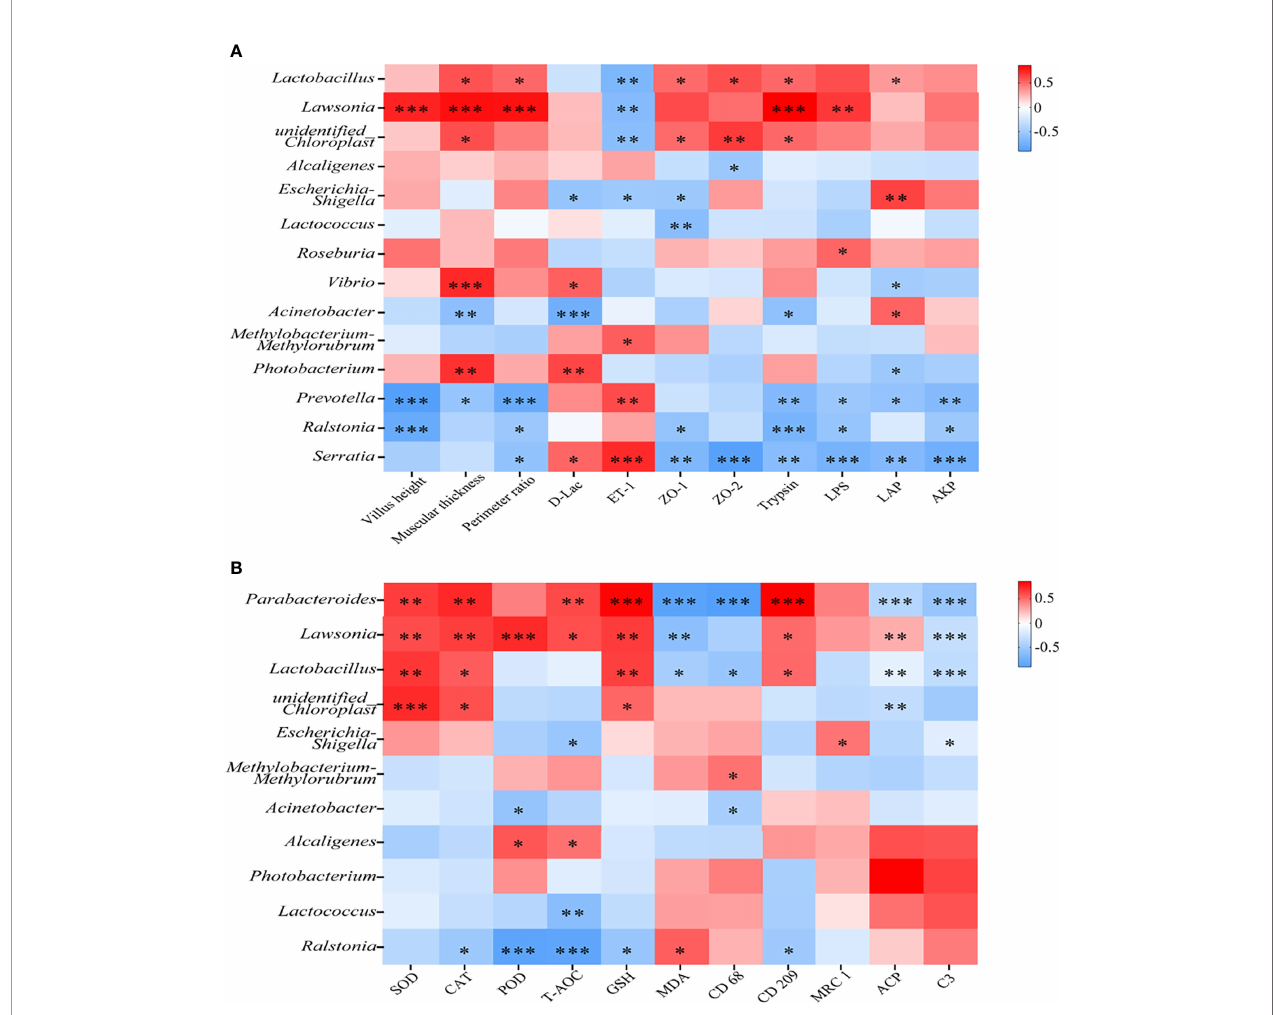
FIGURE 4 | Octanoate-induced changes in the intestinal microbiota had a tight correlation with intestinal repair. The Spearman ’ s correlation coef fi cient between mucosal microbiota and intestinal physical barrier (intestinal VH, MT, PR, the level of D-Lac, ET-1, the relative protein level of ZO-1 and ZO-2), digestive capacity (Trypsin, LPS, a -AMS, LAP, and AKP) were calculated and the heatmap was exhibited (A) . The Spearman ’ s correlation coef fi cient between mucosal microbiota and intestinal antioxidative capacity (SOD, CAT, POD, and the content of T-AOC, GSH, MDA), and in fl ammatory response (the relative protein level of CD68, CD209, MRC1, intestinal ACP, and serum C3) were calculated and the heatmap was exhibited (B) , *0.01 ≤ P < 0.05, ** 0.001 ≤ P < 0.01, *** P <